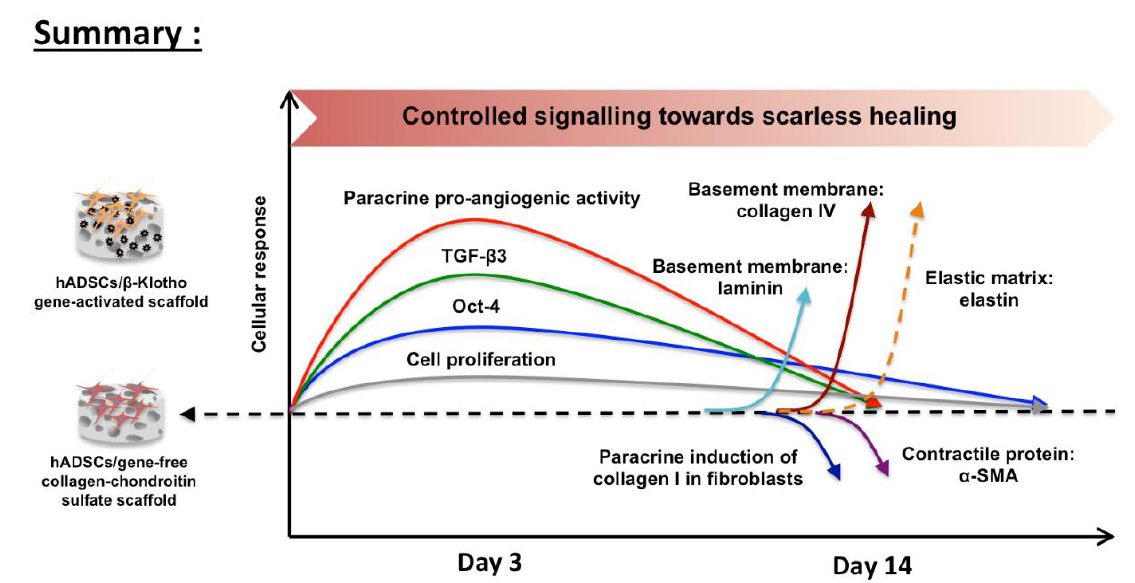
Figure 5. A schematic of the functional impact of β -Klotho gene-activated scaffold on human ADSCs for wound healing applications. The key findings of this study are the (1) transient enhancement of stem cell pluripotency and anti-fibrotic response, (2) improved paracrine control towards angiogenesis, and pro-fibrotic collagen remodeling in dermal fibroblasts, and ultimately, (3) increased maturation of the basement membrane with control over scar-associated proteins’ expression. Dotted lines for elastin matrix imply improved qualitative deposition.